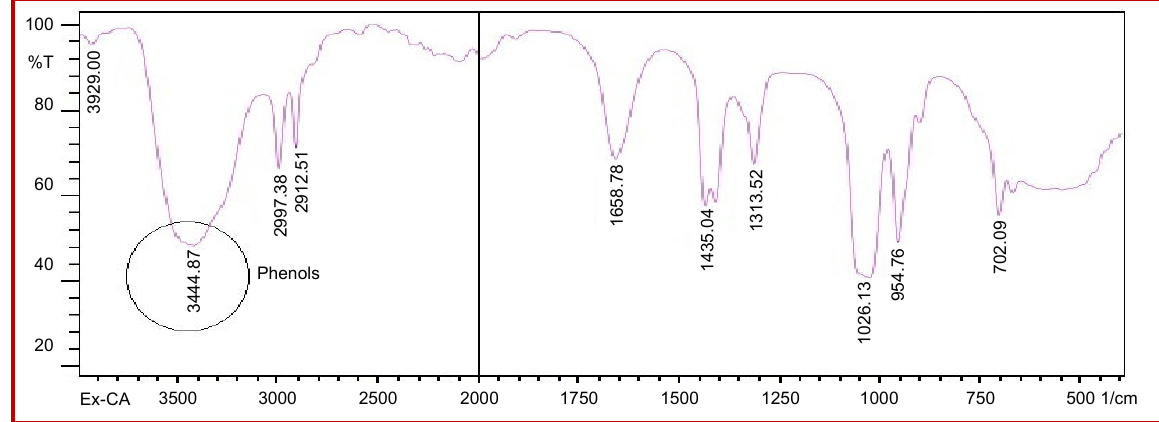
Figure 3: FTIR analysis of optimized Solanum lycopersicum extract